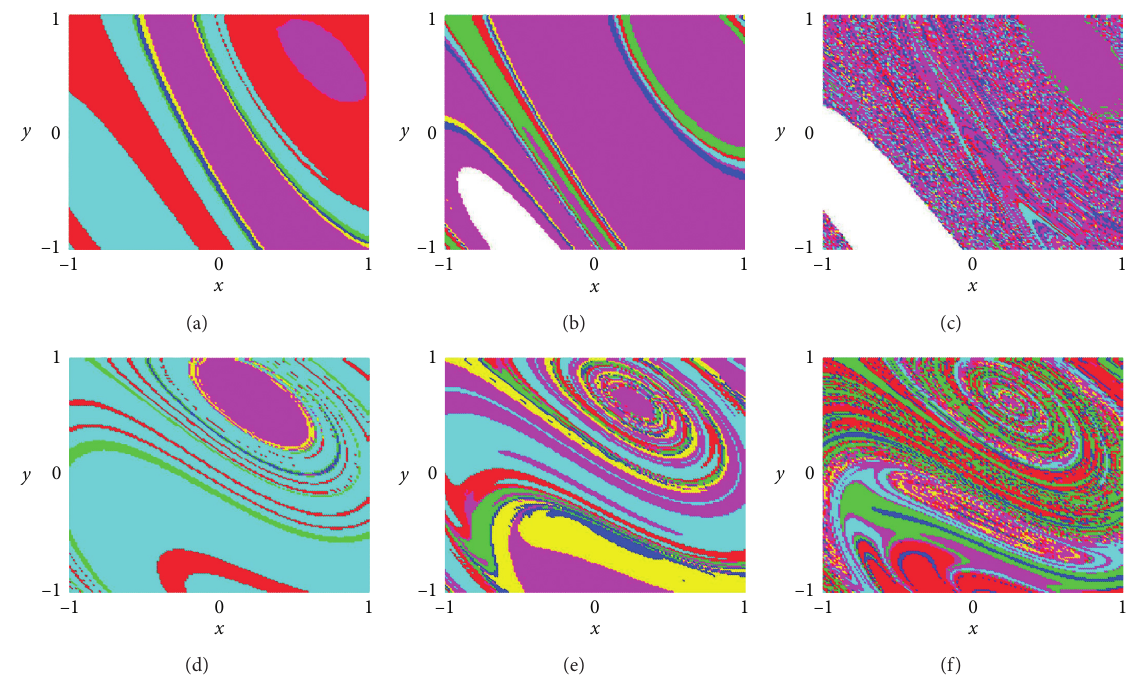
Figure 8: The basins of attraction in the x � 10 and q � 0.97; (b) s � 10 and q � 0.98; (c) s � 10 and 0 - y 0 plane with different parameters: (a) s q � 0.99; (d) s � 5 and q � 0.97; (e) s � 5 and q � 0.98; (f) s � 5 and q �